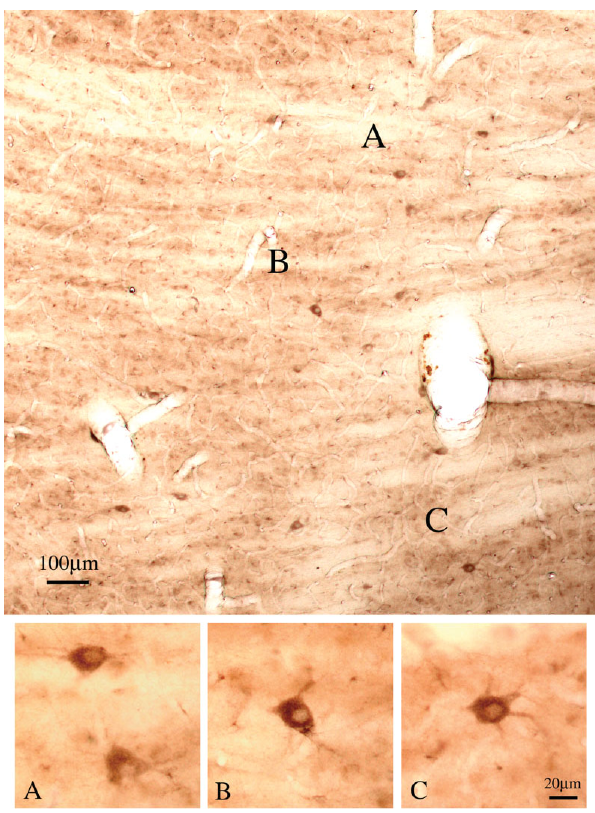
Figure 6. Giant neurons are positive for GluR4 . Coronal section overview through Plil (lateral is to the left), with scattered large neurons that are strongly positive for GluR4. ( A – C ) Four neurons, at higher magnification.